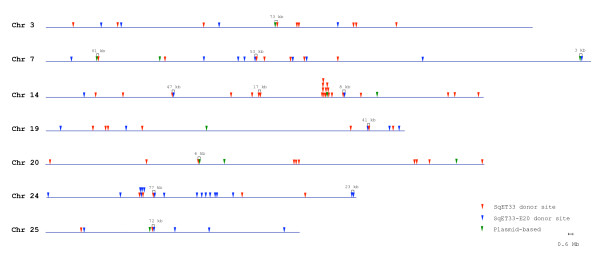
Clustering of Tol2 integrations in the zebrafish genome. Only chromosomes in which two independent Tol2 insertions are mapped within less than 100-kb of one another are shown. Data for the plasmid-based derived integrations were taken from [13] and remapped.